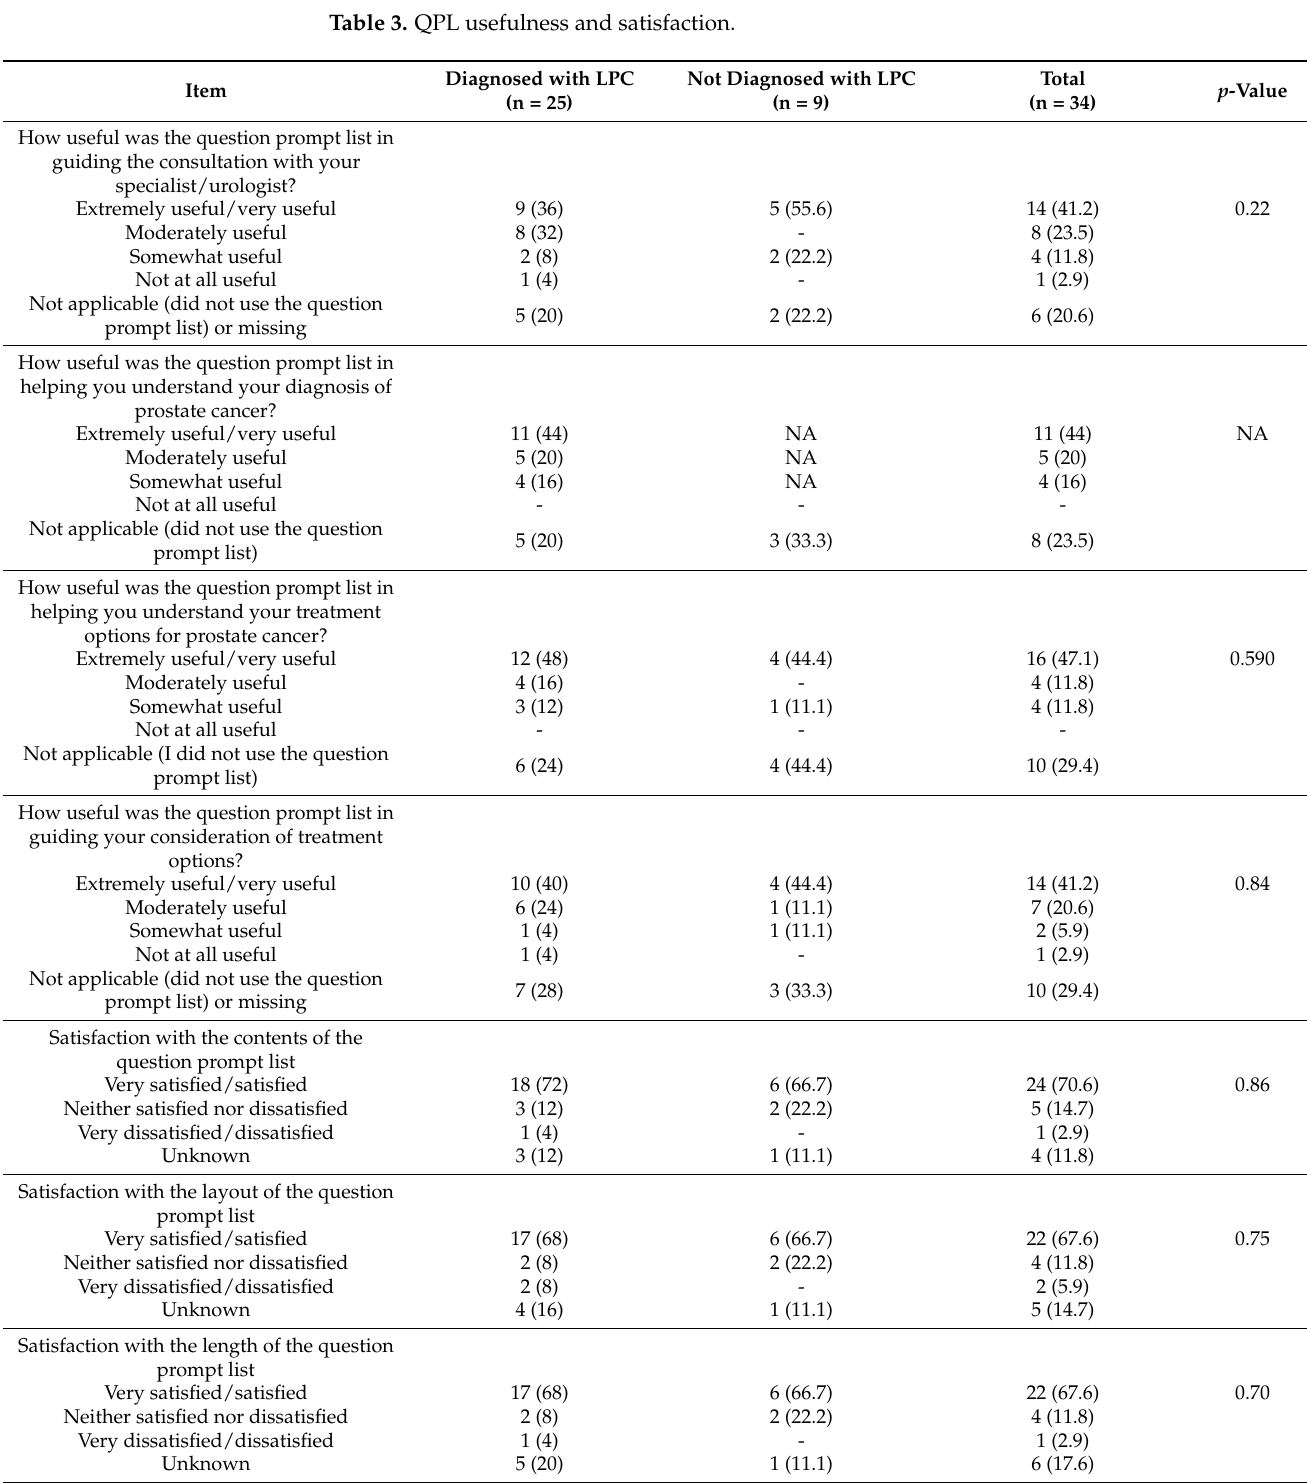
Table 3. QPL usefulness and